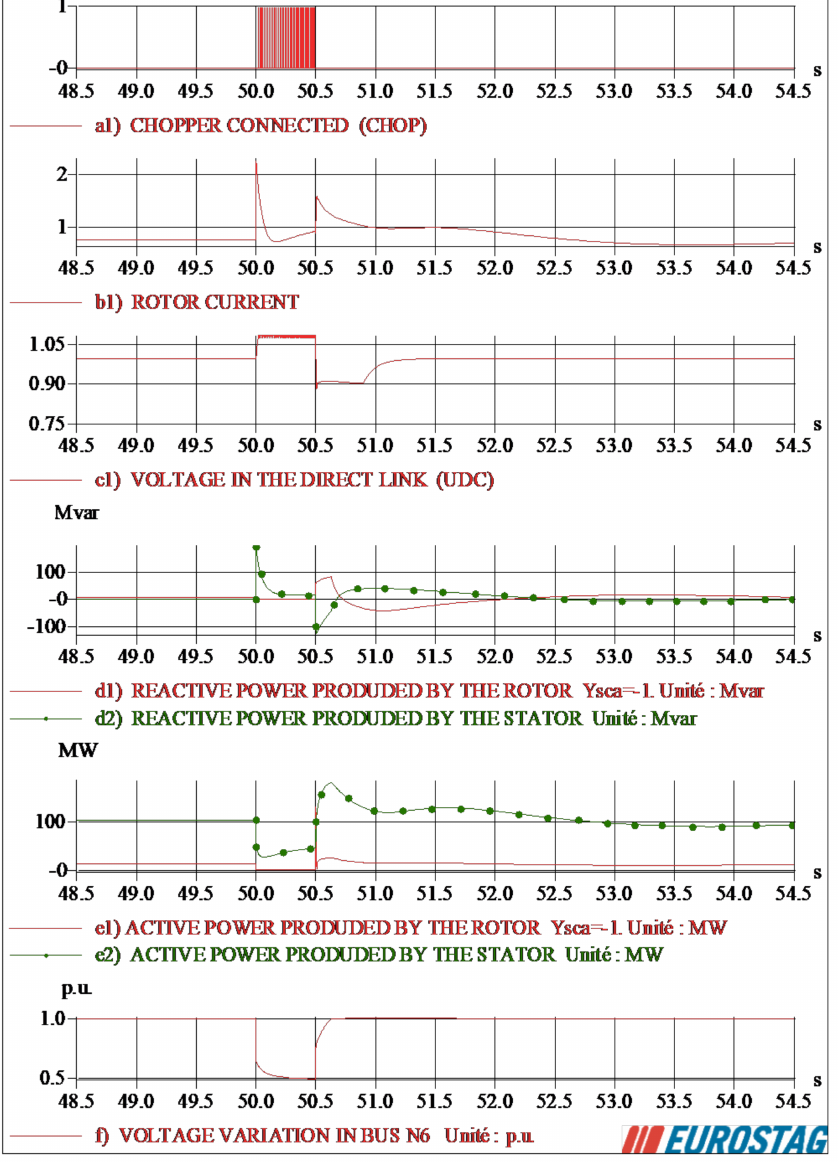
Figure 8. Dynamic analysis of the protection model crowbar with a